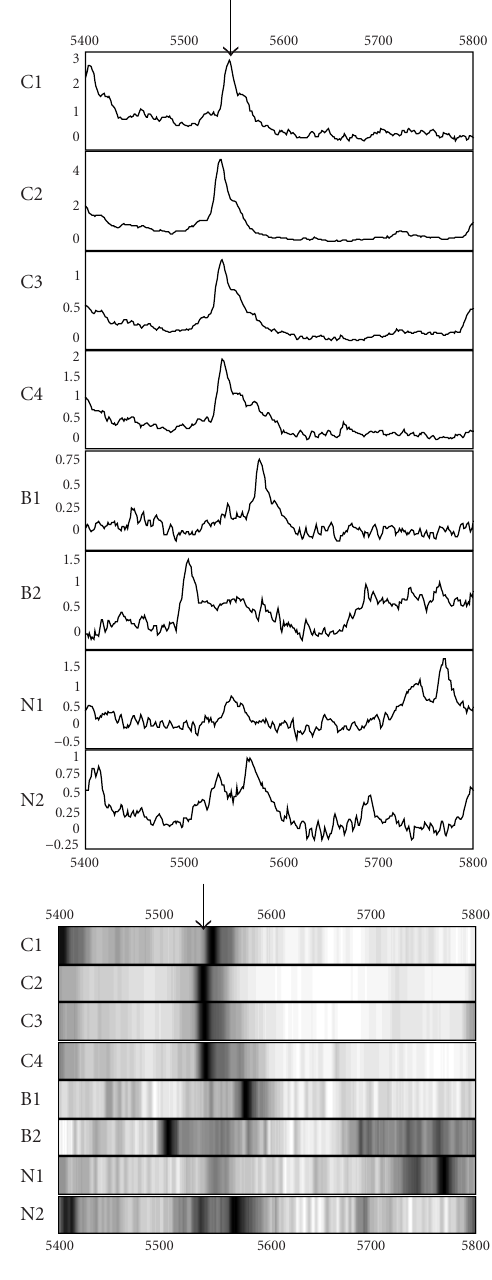
Figure 3. Spectra (top) and grey-scale or gel views (bottom) of the peaks (arrows) forming the splitting rules. The protein peak was detected on IMAC chip. The peak appears to be upregulated in the cancer (C1–C4) compared to the benign (B1-B2) and nor- mal (N1-N2)